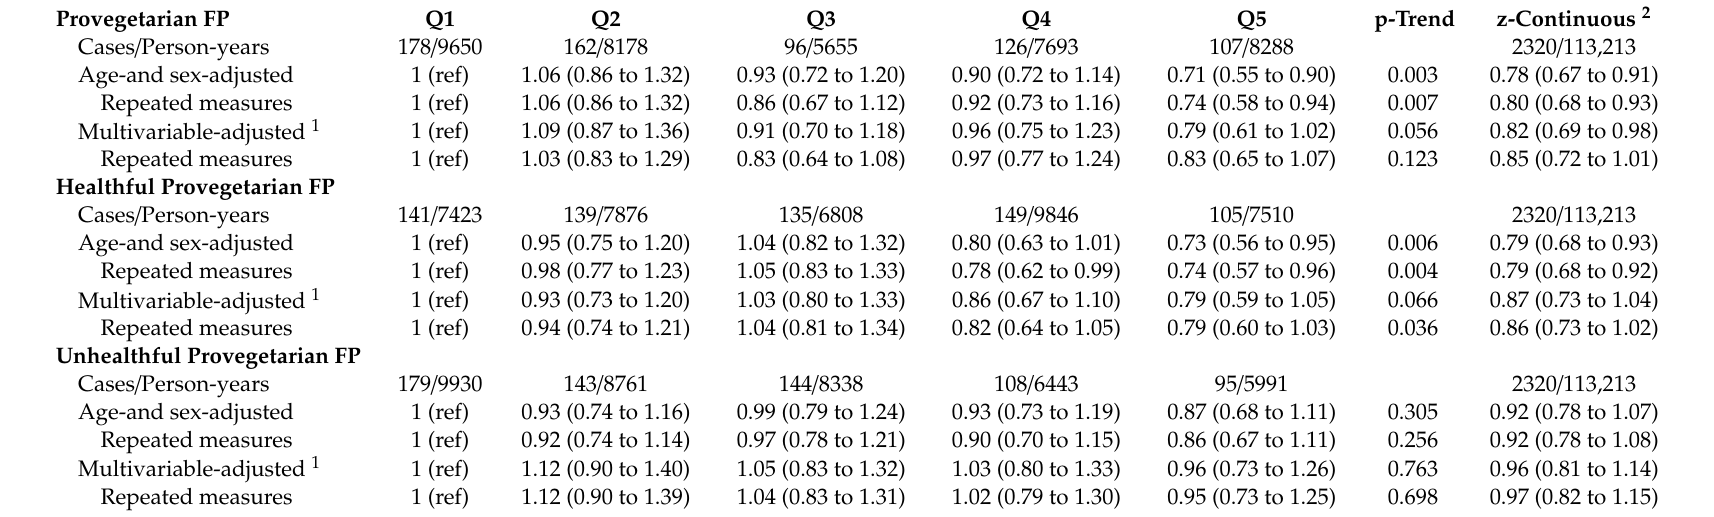
Table 4. Risk of obesity (HR and 95% CI) 1 in overweight participants (n = 3935) according to quintiles of di ff erent provegetarian food patterns (FP). Provegetarian